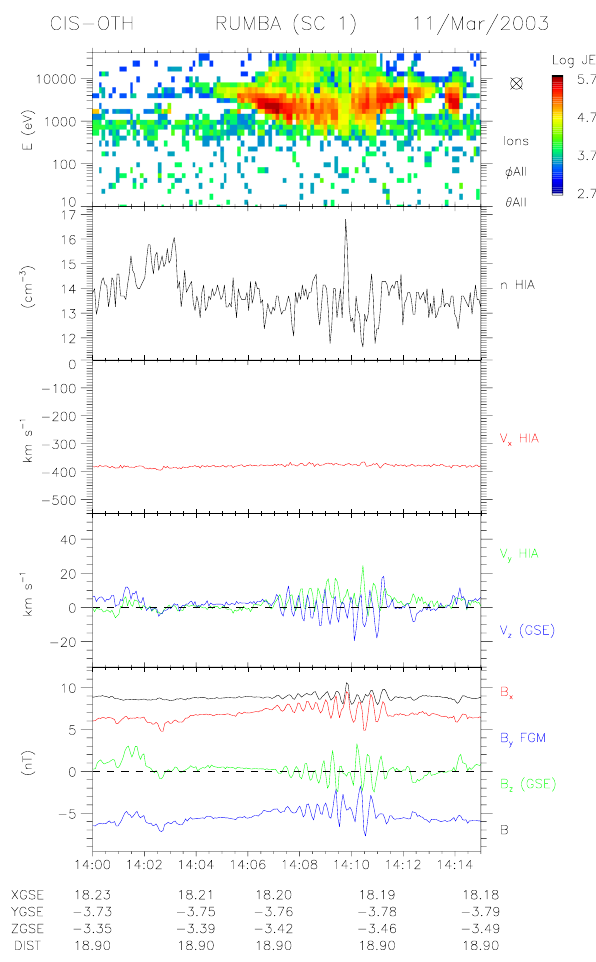
Fig. 1. Top panel shows the time-energy spectrogram from the CIS- HIA sensor for 11 March 2003, 14:00–14:15UT. The successive panels display respectively the ion density, the GSE components of the solar wind velocity, the interplanetary magnetic field GSE components and magnitude from FGM